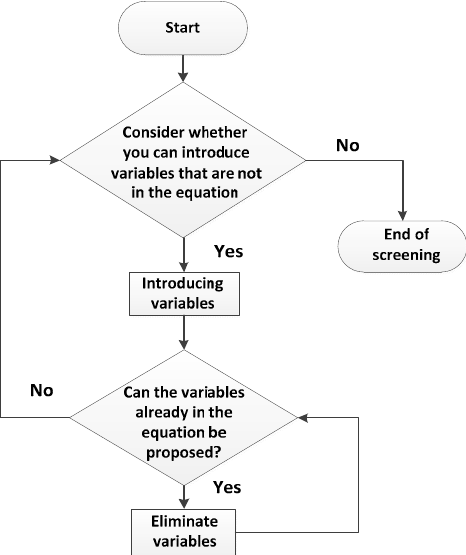
Figure 1. Steps of the stepwise regression algorithm.